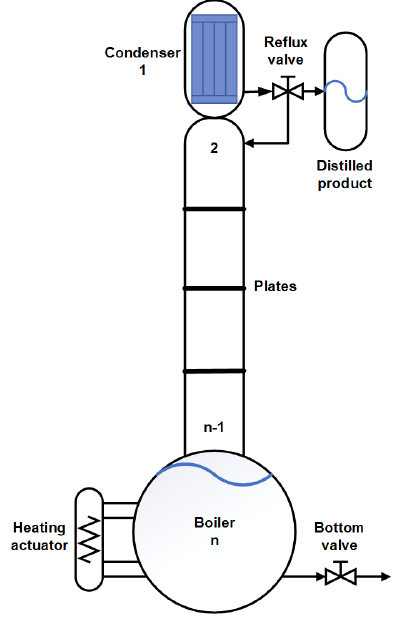
Figure 1. Distillation column simplified